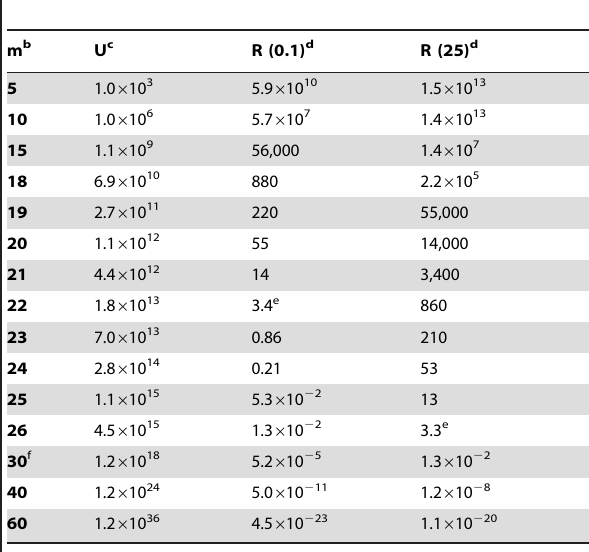
a. See Table S1 for a more extensive list and details o calculations. b. m=length of randomized sequence. c. U=4 m , the number of possible unique sequences. d. R=the average representation of each unique molecule in a pool, for the